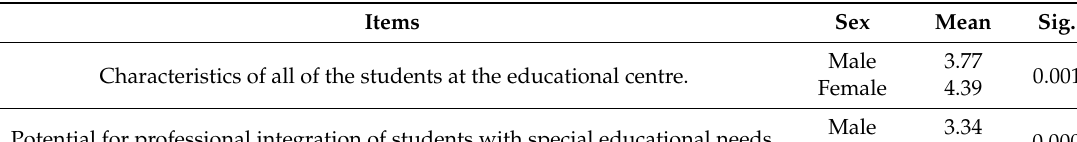
Table 6. Di ff erences in relation to the gender